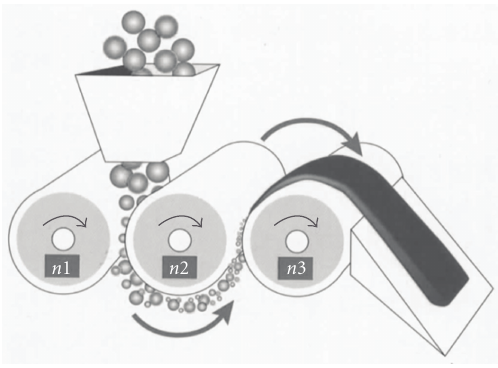
Figure 1: Illustration of mixing mechanism by three-roll